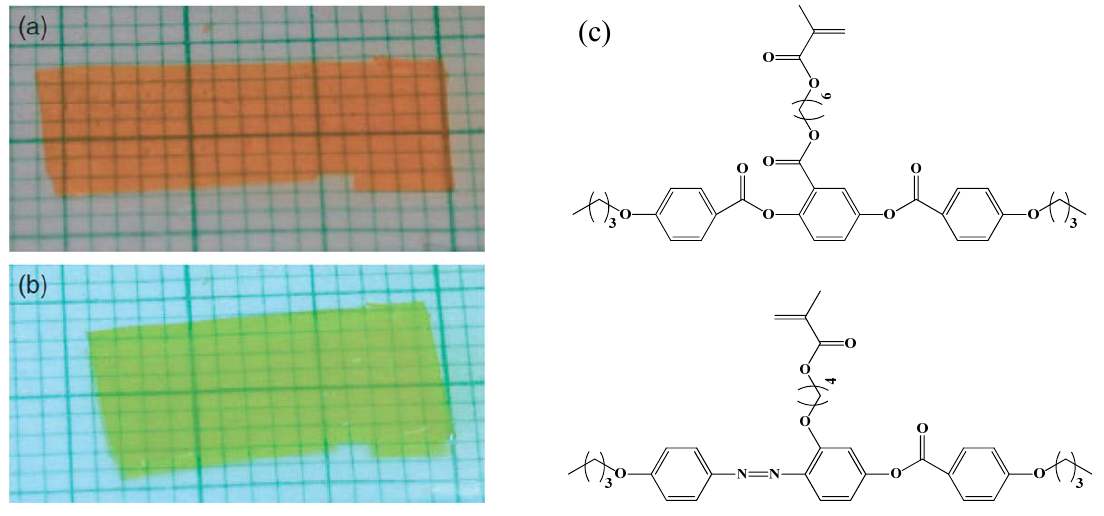
Figure 10. Side-on photo-responsive Liquid-Crystalline Network ( LCN) film, ( a ) before UV irradiation; ( b ) film contraction under UV irradiation; ( c ) chemical structures of side- on LC monomers used for the synthesis of LCE. Reprinted with permission